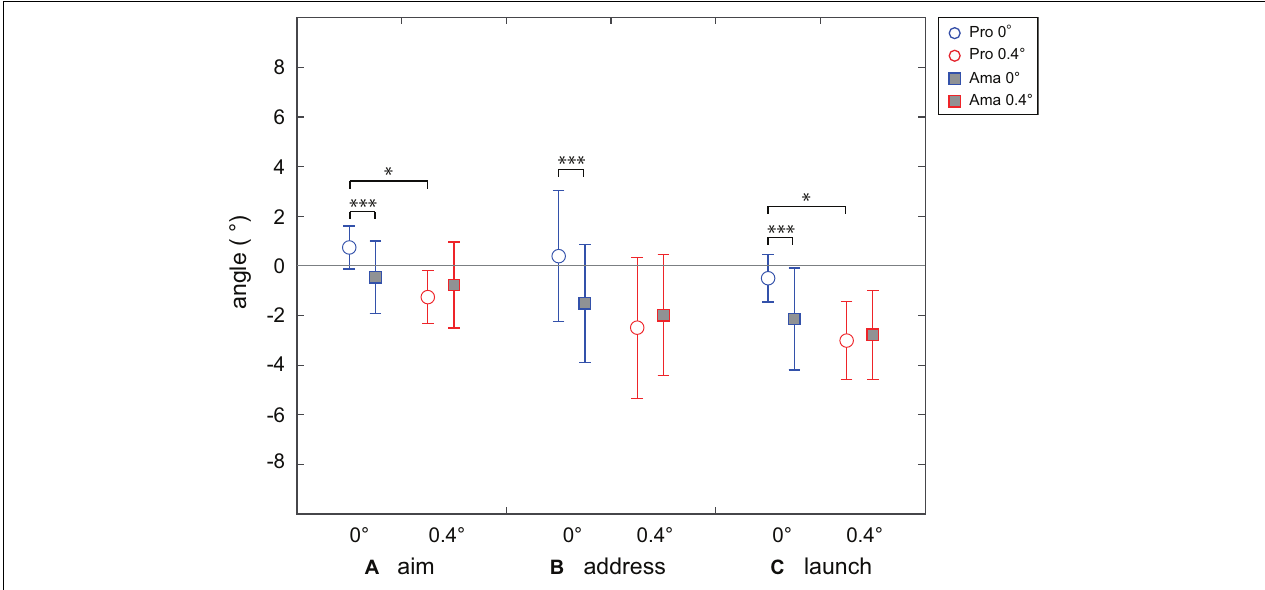
FIGURE 4 | Average angles of each phase (A–C) in the 0- and 0.4-degree conditions. The angle 0 refers to the center of the target. Negative values indicate the position to the left of the target’s center, while positive values indicate the position to the right of the target’s center. * p < 0.05 and *** p < 0.001.